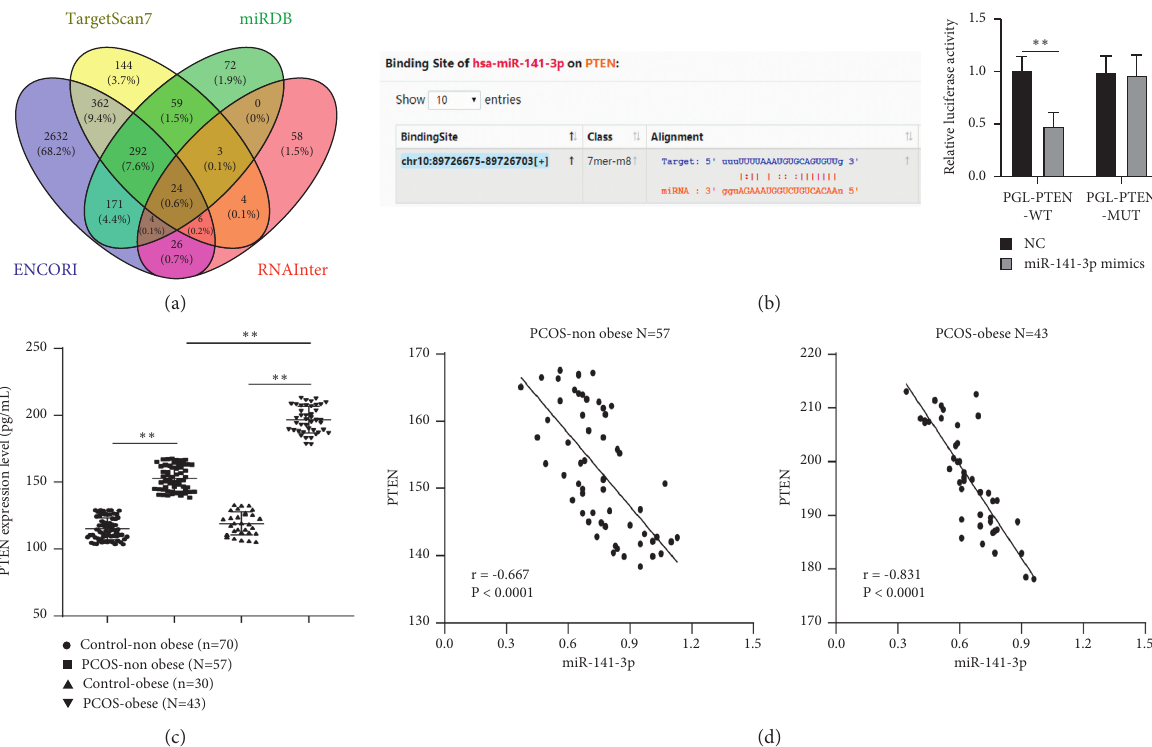
Figure 3: PTEN was highly expressed in serum of PCOS patients and negatively correlated with miR-141-3p. (a) Downstream target genes of miR-141-3p were predicted through TargetScan, StarBase, RNAInter, and miRDB database and intersections were taken; (b) target relation between miR-141-3p and PTEN was verified by dual-luciferase reporter assay; (c) PTEN expression in serum of PCOS patients was detected by ELISA; (d) correlation between miR-141-3p expression and PTEN expression in PCOS-nonobese patients and PCOS-obese patients was analyzed using Pearson’s correlation analysis. Data are expressed as mean ± standard deviation. Data in (b) were analyzed using t -test and data in (c) were analyzed using one-way ANOVA, followed by Tukey’s multiple comparisons test. ∗∗ P < 0 .